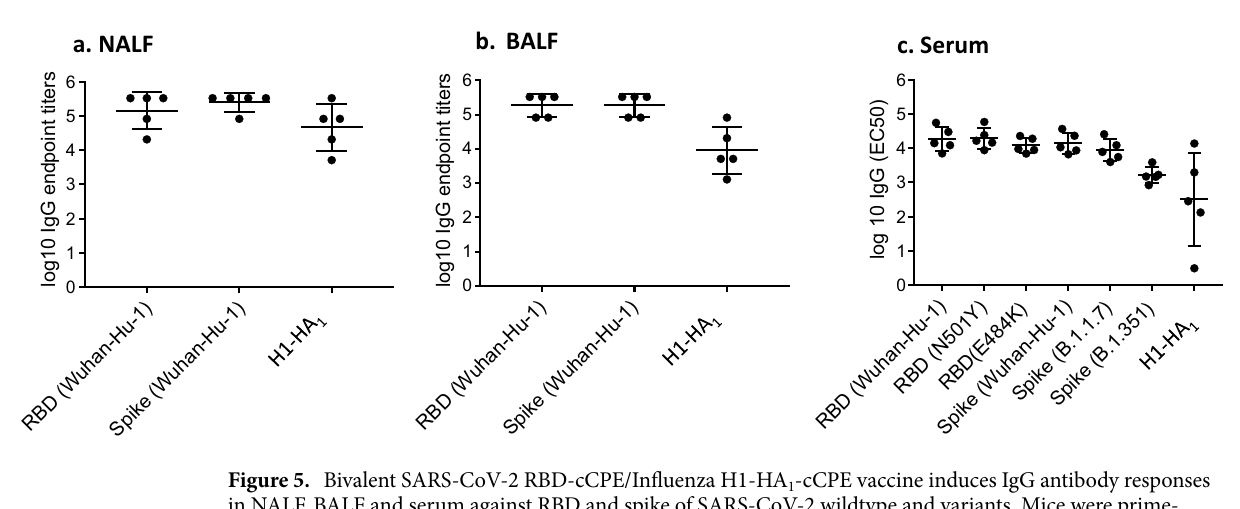
Figure 5. Bivalent SARS-CoV-2 RBD-cCPE/Influenza H1-HA 1 -cCPE vaccine induces IgG antibody responses in NALF, BALF and serum against RBD and spike of SARS-CoV-2 wildtype and variants. Mice were prime- boost immunized intranasally (days 0 and 21) with bivalent SARS-CoV-2 RBD-cCPE/influenza H1-HA 1 - cCPE vaccine, adjuvanted with Riboxxim. NALF, BALF and sera were obtained on day 28, 1 week after the boost, diluted in fourfold steps, and assayed for IgG antibodies in Luminex with recombinant monomeric RBD (Wuhan-Hu-1/wildtype, or point mutations N501Y, or E484K), or recombinant trimeric spike protein (Wuhan-Hu-1, B.1.1.7, B.1.351), or recombinant monomeric H1-HA 1 (A/swine/Guangxi/3843/2011(H1N1), respectively. Endpoint titers (NALF, BALF) or EC 50 (serum) were calculated where applicable. Log10 of endpoint titers or EC 50 were plotted with geometric mean ± geometric